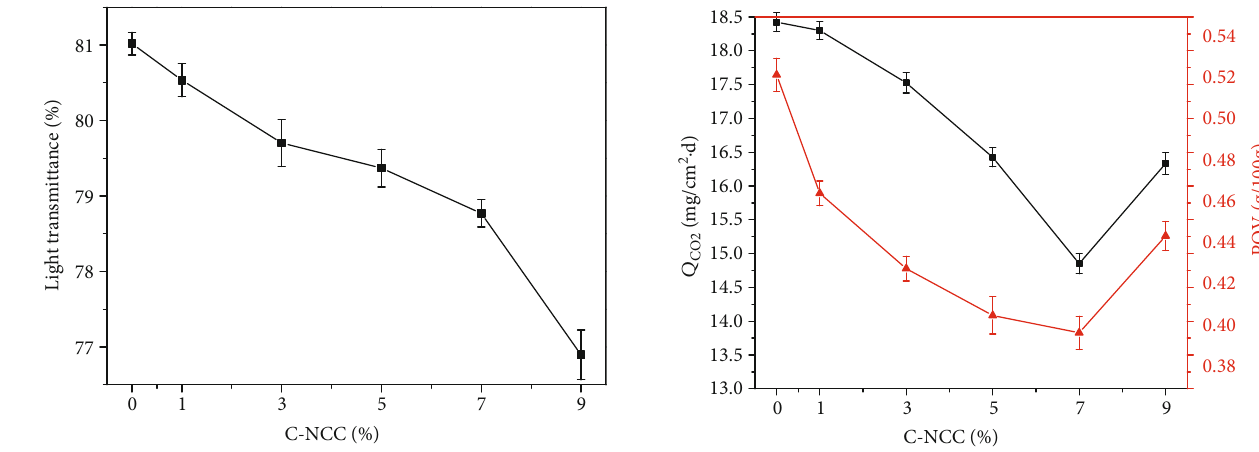
Figure 1: E ff ect of the C-NCC content on the light transmittance of the composite fi lms.